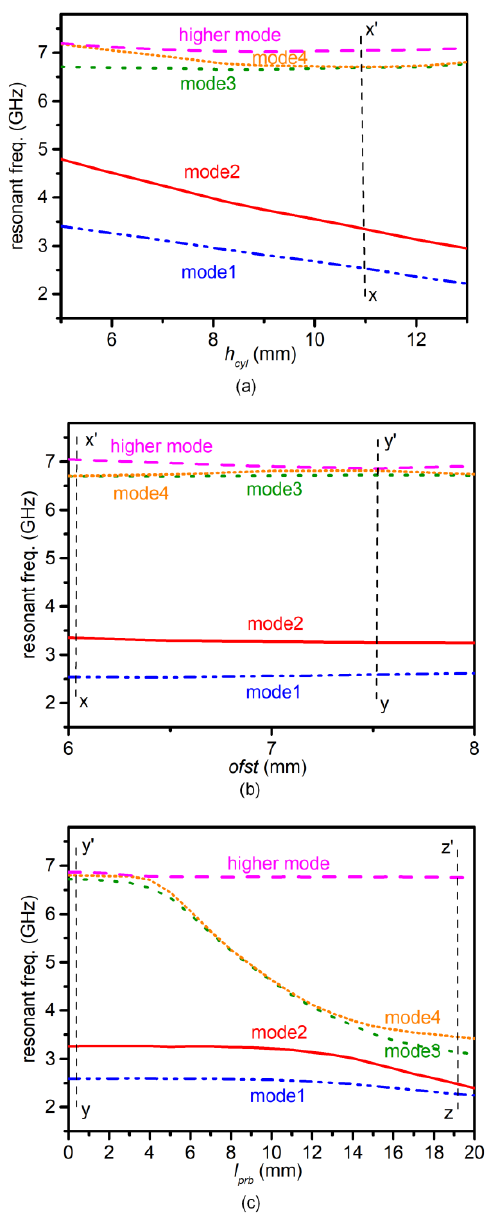
Figure 3. Mode-chart comprised of resonant frequencies of the first five resonant modes against different parameters of the filter: ( a ) resonant frequencies against height of the cylinders h cyl ; ( b ) resonant frequencies against offset shift parameter ofst ; ( c ) resonant frequencies against length of coupling probes l prb .